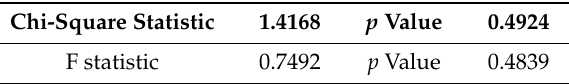
Table 7. ARCH-LM test (with two